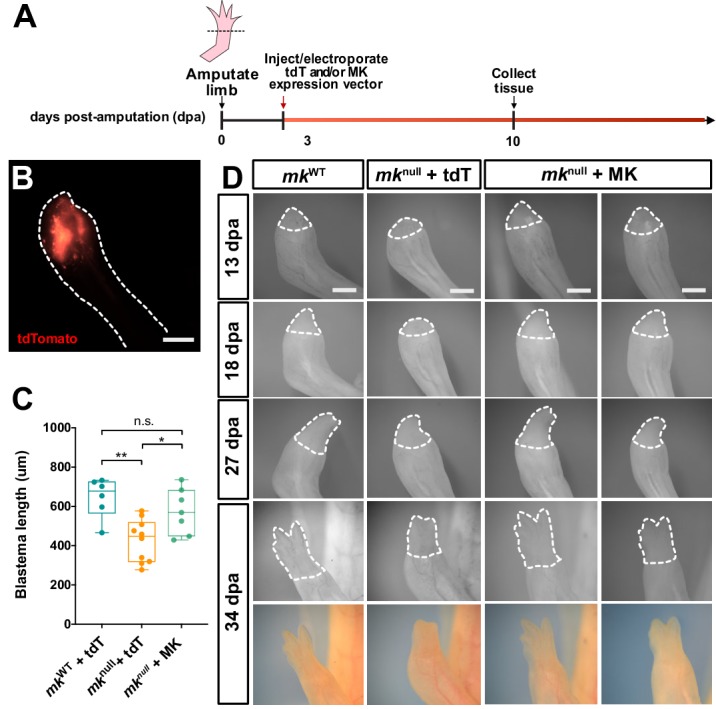
Mk overexpression in mknull regenerating limbs rescues delayed regeneration.(A) Experimental schematic of rescue experiment. Either a pCAG-MK and/or pCAG-tdTomato control overexpression construct was injected and electroporated into the regenerating limbs of wildtype or mknull animals at 3 dpa. (B) Representative image of tdTomato fluorescence in a pCAG-MK/pCAG-tdTomato co-electroporated regenerating limb at 14 dpa (outlined in white dotted line). (C) Quantification of blastema length at 13 dpa. One-way ANOVA analyses were employed on each set of data for statistical analysis (N = 6 mkWT + tdT, 10 mknull+tdT, 7 mknull + MK). (D) Representative time course images of regenerating mkWT and mknull limbs electroporated with pCAG-tdTomato and/or pCAG-MK constructs. Two different rescue animals are shown here. Graphs are mean ± SD. **p<0.005, *p<0.05. Scale bars, B, D: 1 mm. n.s., not significant; dpa, days post-amputation.